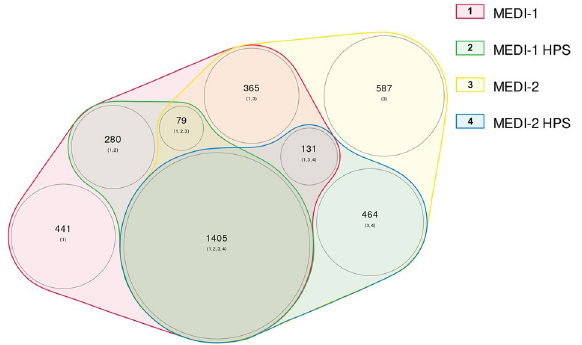
Figure 4. Weighted Venn diagram of the differences and overlap of medications included in MEDI-1, MEDI-1 HPS, MEDI-2, and MEDI-2 HPS. Each colored area represents a different resource. The larger number in each colored area represents the number of medications found in the combination of resources labeled by the smaller numbers in the parenthesis. The numbers in the parenthesis correspond with the numbers in the color legend. The circle area sizes are proportional to the number of medications found within the corresponding resource(s). HPS high precision subset.